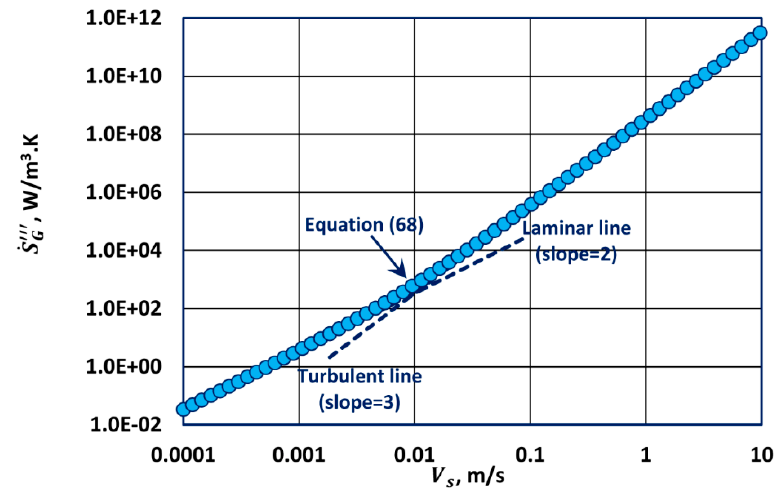
. (cid:48)(cid:48)(cid:48) S Figure 20. Prediction of Figure 20. Prediction of (cid:1845)(cid:4662) (cid:3008)(cid:4593)(cid:4593)(cid:4593) for consolidated porous medium over a broad range of fluid superficial G for consolidated porous medium over a broad range of fluid superficial velocity under the conditions: T = 298.15 K, µ = 1mPa · s, ρ = 1000 kg / m 3 , k = 10 − 12 m 2 , β = 10 8 m − 1 . velocity under the conditions: (cid:1846) = 298.15 K, (cid:2020) = 1mPa·s, (cid:2025) = 1000 kg/m 3 , (cid:1863) = 10 − 12 m 2 , (cid:2010) = 10 8 m − 1 . The The data points are generated using Equation data points are generated using Equation (68).